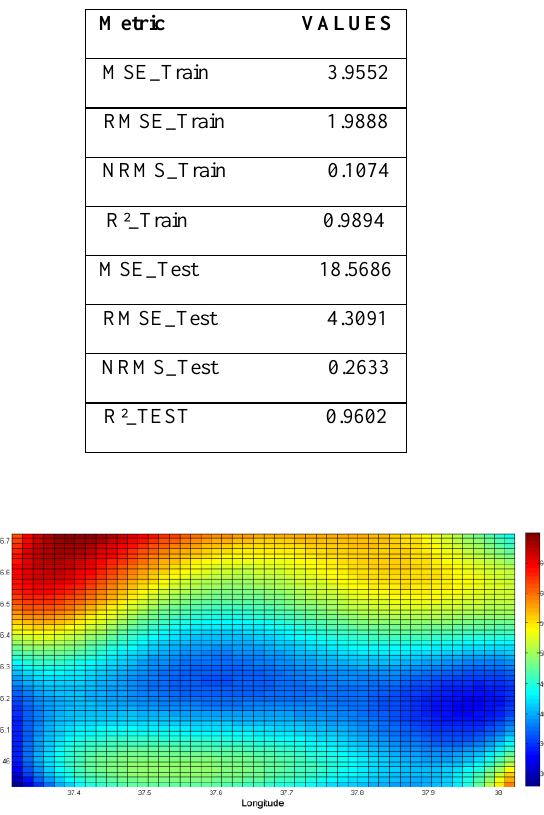
Table (2). Resulted of the model